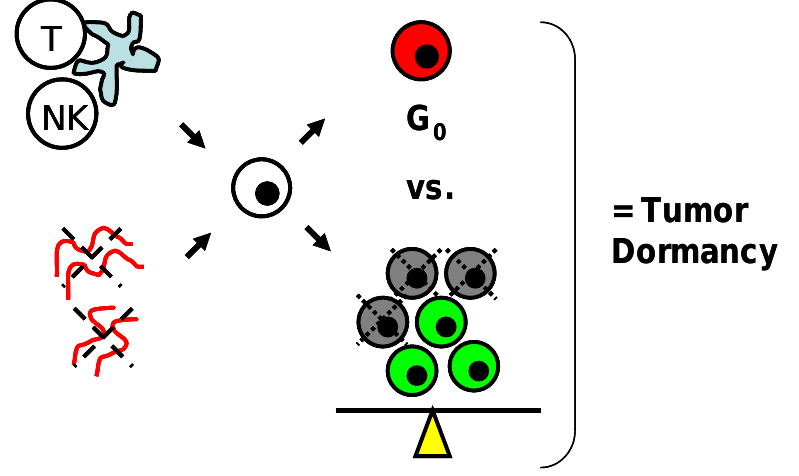
Figure 1. Impaired angiogenesis (red vessels with dotted X) and immune regulation (T, NK cell) are the two major proposed mechanisms for maintenance of tumor dormancy. The net result is that single tumor cells (white) enter a state of cell cycle arrest (= G or there is a balance between the number of cells proliferating (green) and those undergoing apoptosis (gray with dotted